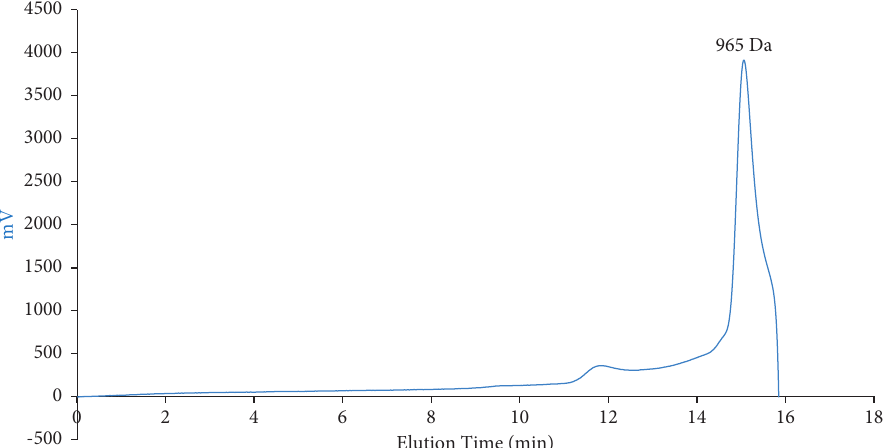
Figure 3: Molecular weight determination curve of Inonotus obliquus oligosaccharide